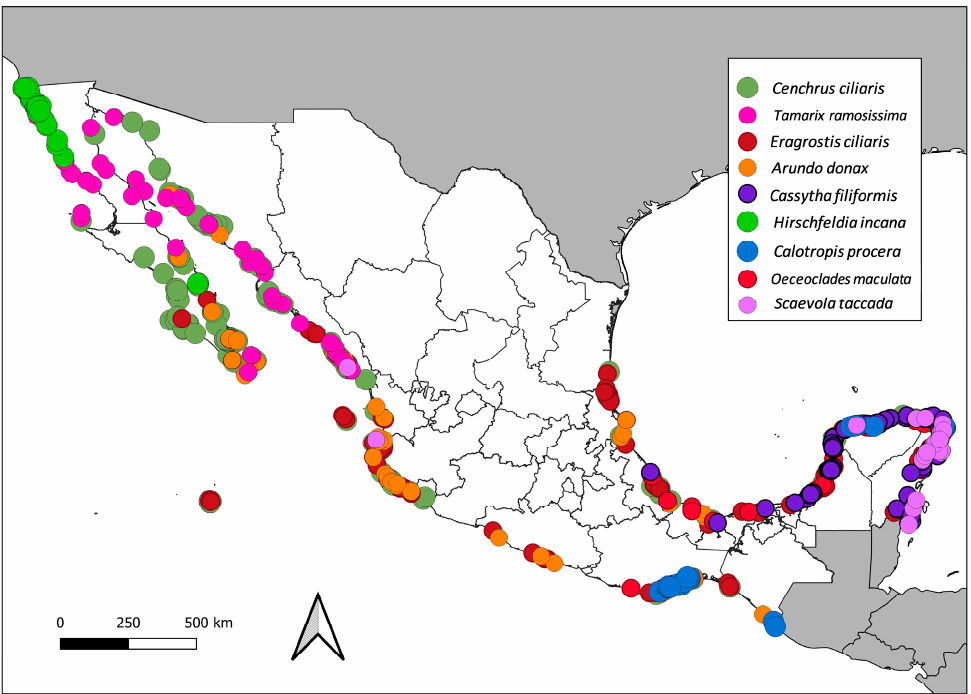
Figure 6. Combined geographic distribution of the nine exotic plants reported as invasive on Mexican coastal dunes.